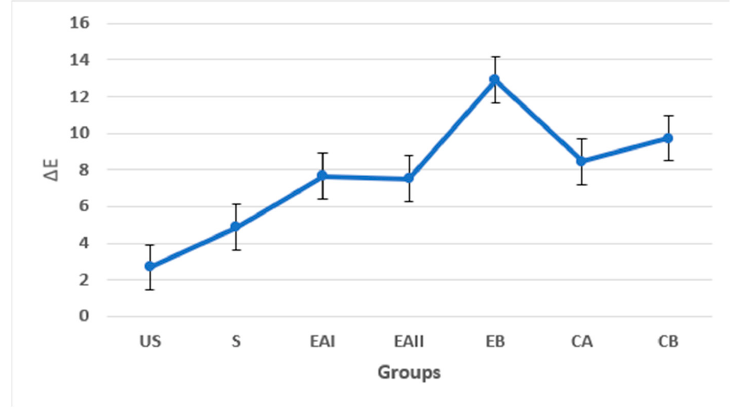
Figure 6. Trend of Δ E across groups in comparison to the Unstained (US) and Stained (S) tooth Figure 6. Trend of ∆ E across groups in comparison to the Unstained (US) and Stained (S) tooth samples . EB exhibited Δ E values in a di ff erent range of Δ E > 10 as compared to all the other groups. samples. EB exhibited ∆ E values in a different range of ∆ E > 10 as compared to all the other groups. Table 4. Mean microhardness values of the tooth samples after treatment.